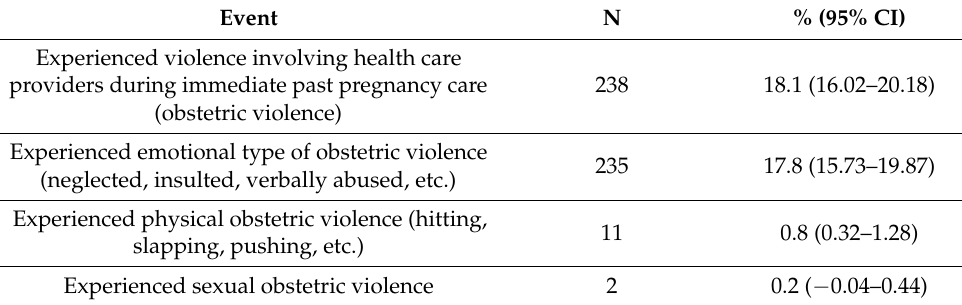
Table 1. Prevalence of obstetric violence.